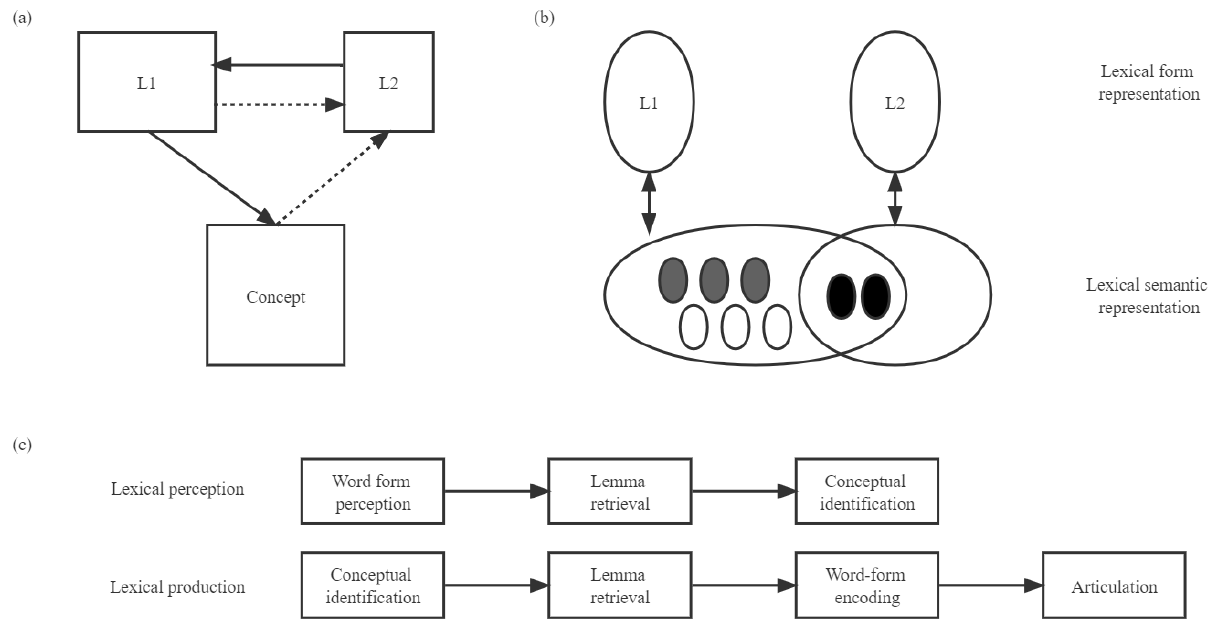
Figure 1. The details of the bilingual models. Note. ( a ) The revised hierarchical model. From the “Category interference in translation and picture naming: Evidence for asymmetric connection be‑ tween bilingual memory representations” by J. Kroll and E. Stewart, 1994, Journal of Memory and Language, 33 (2), 149–174. L1 refers to the L1 lexical representation, L2 refers to the L2 lexical rep‑ resentation, and the concept refers to the conceptual representation shared by the L1 and L2 lexical representations. ( b ) The sense model. From “The role of polysemy in masked semantic and trans‑ lation priming” by M. Finkbeiner et al., 2004, Journal of Memory and Language , 51 (1), 1–22. L1 and L2 refer to the lexical representation of L1 and L2. The white and light grey circles within the se‑ mantic representation refer to the specific senses belonging to L1, and the dark grey circles refer to the shared senses between L1 and L2. ( c ) The WEAVER++ model. Adapted from “Goal‑referenced selection of verbal action: Modeling attentional control in the Stroop task” by A. Roelofs, 2003, Psy‑ chological Review , 110 (1),